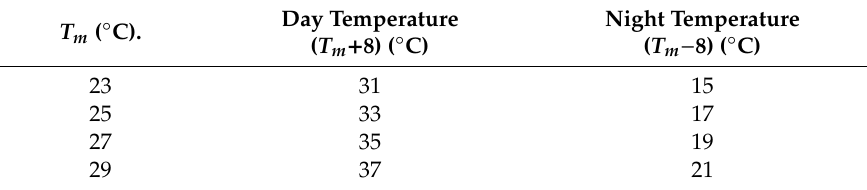
Table 3. Day and night temperatures for di ff erent values of daily mean temperature ( T m ) and a daily temperature amplitude ( A ) of 8 ◦ C.